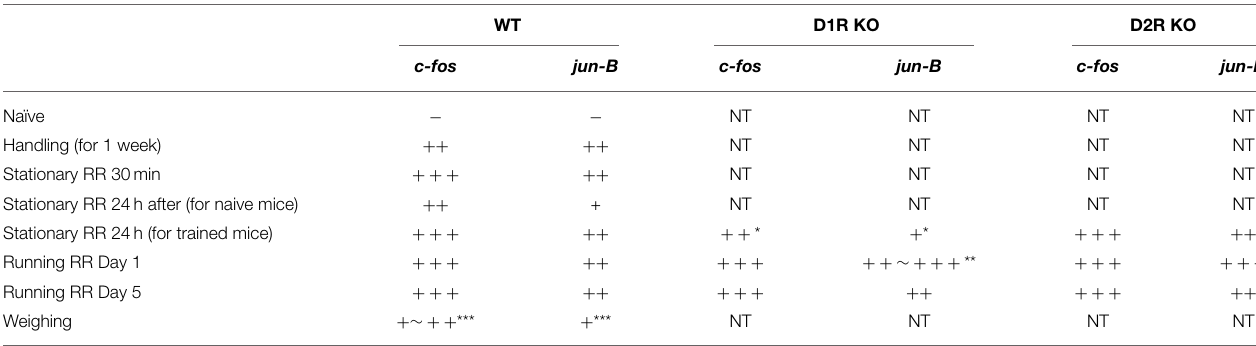
TABLE 1 | c-fos and jun-B expressions in cerebellar